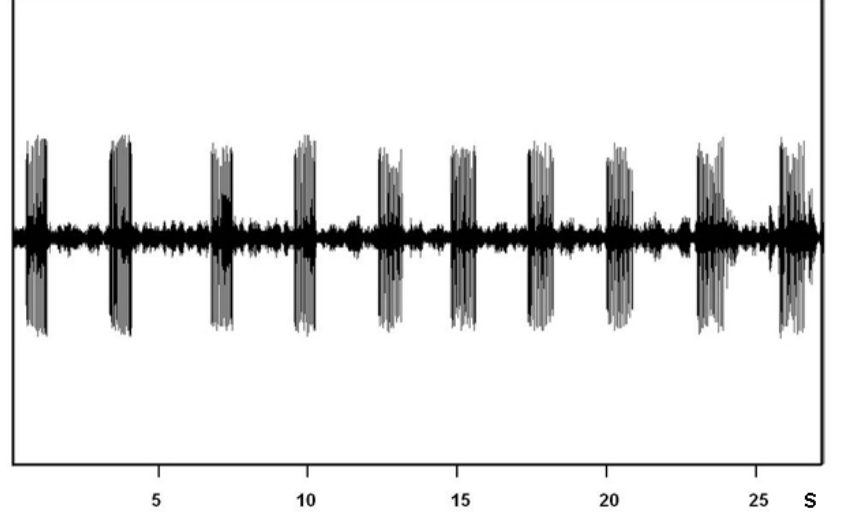
Figure 8. Wave form of a series of ten calls from Choerophryne multisyllaba sp. n.